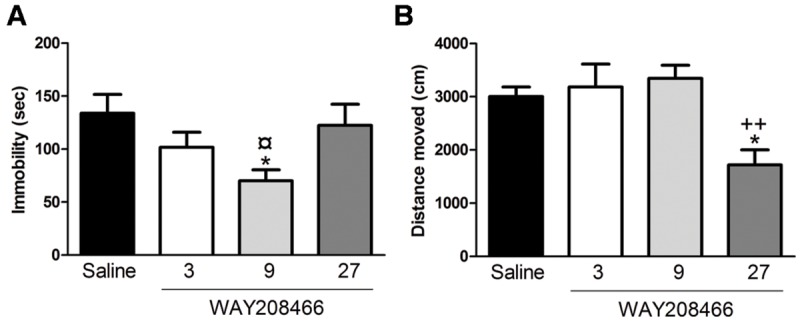
Effects of WAY208466 treatment in the forced swim test (FST) and open field test (OFT). (A) Immobility duration in the FST showing antidepressant-like effect of WAY208466 after 9 mg/kg (ip). (B) Total distance moved during 5 min in the OFT. WAY208466 at 27 mg/kg (ip) caused motor impairment compared to the saline group. ∗p < 0.05 compared to saline group, ¤p < 0.05 compared to 27 mg/kg. ++p < 0.01 compared to 9 mg/kg WAY208466 group. Mean ± SEM; n = 8 mice per group.